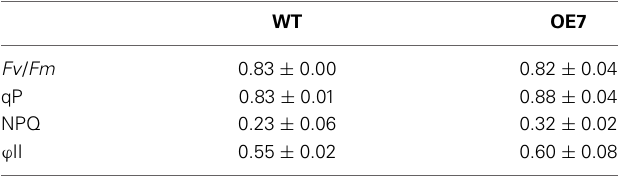
Table 1 | Chlorophyll fluorescence parameters for WT and